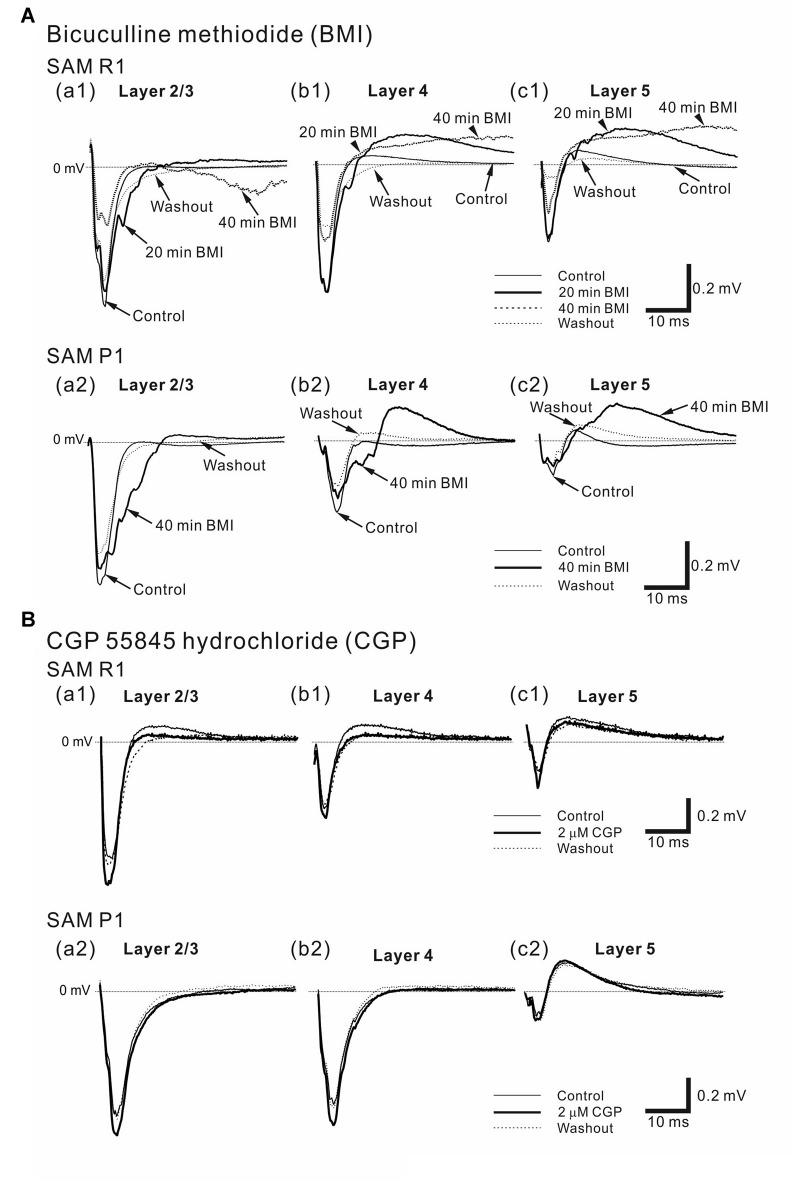
Effects of bicuculline methiodide (BMI) and CGP 55845 hydrochloride (CGP) on cortical LFP responses evoked by stimulation at one site in L4. (A) Typical examples of BMI effects on LFPs in older SAMR1 (13-month old) and SAMP1 (13-month old) mice. (top) In SAMR1, typical LFP responses in L2/3 (a1), L4 (b1) and L5 (c1) are illustrated in the control, 4-μM BMI (20 and 40 min after superfusion), and washout conditions. (bottom) Similarly, in SAMP1, typical LFP responses in L2/3 (a2), L4 (b2) and L5 (c2) are illustrated in the control, 4-μM BMI (40 min after superfusion), and washout conditions. (B) Representative examples of effects of CGP on LFPs in older SAMR1 (13-month old, top) and SAMP1 (13-month old, bottom) mice. (top) In SAMP1, typical LFP responses in L2/3 (a1), L4 (b1) and L5 (c1) are illustrated in the control, 2-μM CGP (30 min after superfusion), and washout conditions. (bottom) Similarly, typical LFP responses in L2/3 (a2), L4 (b2) and L5 (c2) are illustrated in the control, 2-μM CGP (30 min after superfusion), and washout conditions.